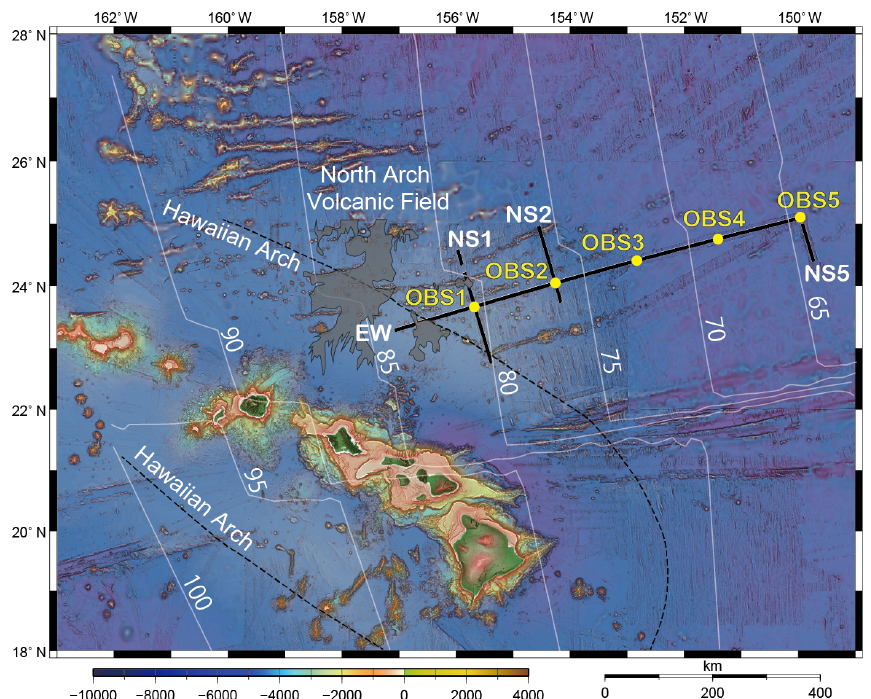
Figure 3. Map showing the seismic survey lines (black) northeast off the Hawaiian Islands. Yellow circles indicate the location of ocean bottom seismographs (OBSs). Thin white lines indicate seafloor age (Ma) from Müller et al. (2008). The black dashed line indicates the axis of the Hawaiian Arch (e.g., Ballmer et al., 2011; Holcomb and Robinson, 2004). The North Arch Volcanic Field, indicated by gray shading, is characterized by strong acoustic reflectivity (Clague et al., 1990, 2002; Normark et al., 1989).